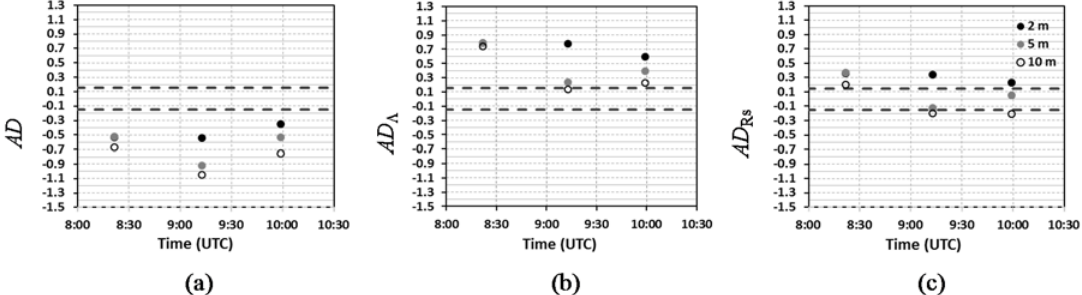
Figure 11. Absolute difference, AD ( unitless ), of λ ET ( a ), and ET D based on Λ scaling factor ( b ), and R s scaling factor ( c ) during the image acquisition day. The two dashed grey lines indicate an acceptable range of variability of ±15%.